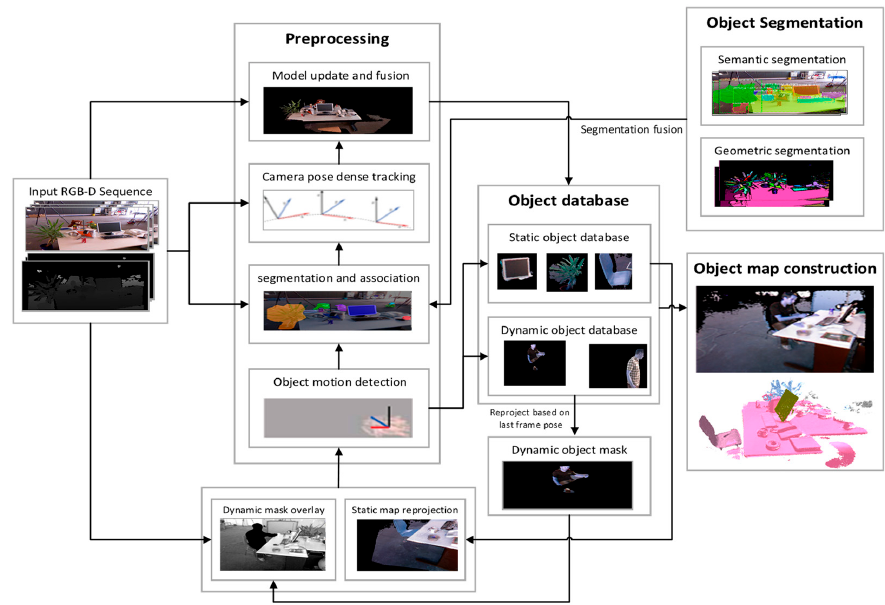
Figure 1. Overview of the system pipeline. Images data captured by an RGB-D camera serve as the input data for the motion detection, segmentation, camera pose tracking, and map construction modules, among others. Then, the precise camera pose and object-level semantic map can be obtained.